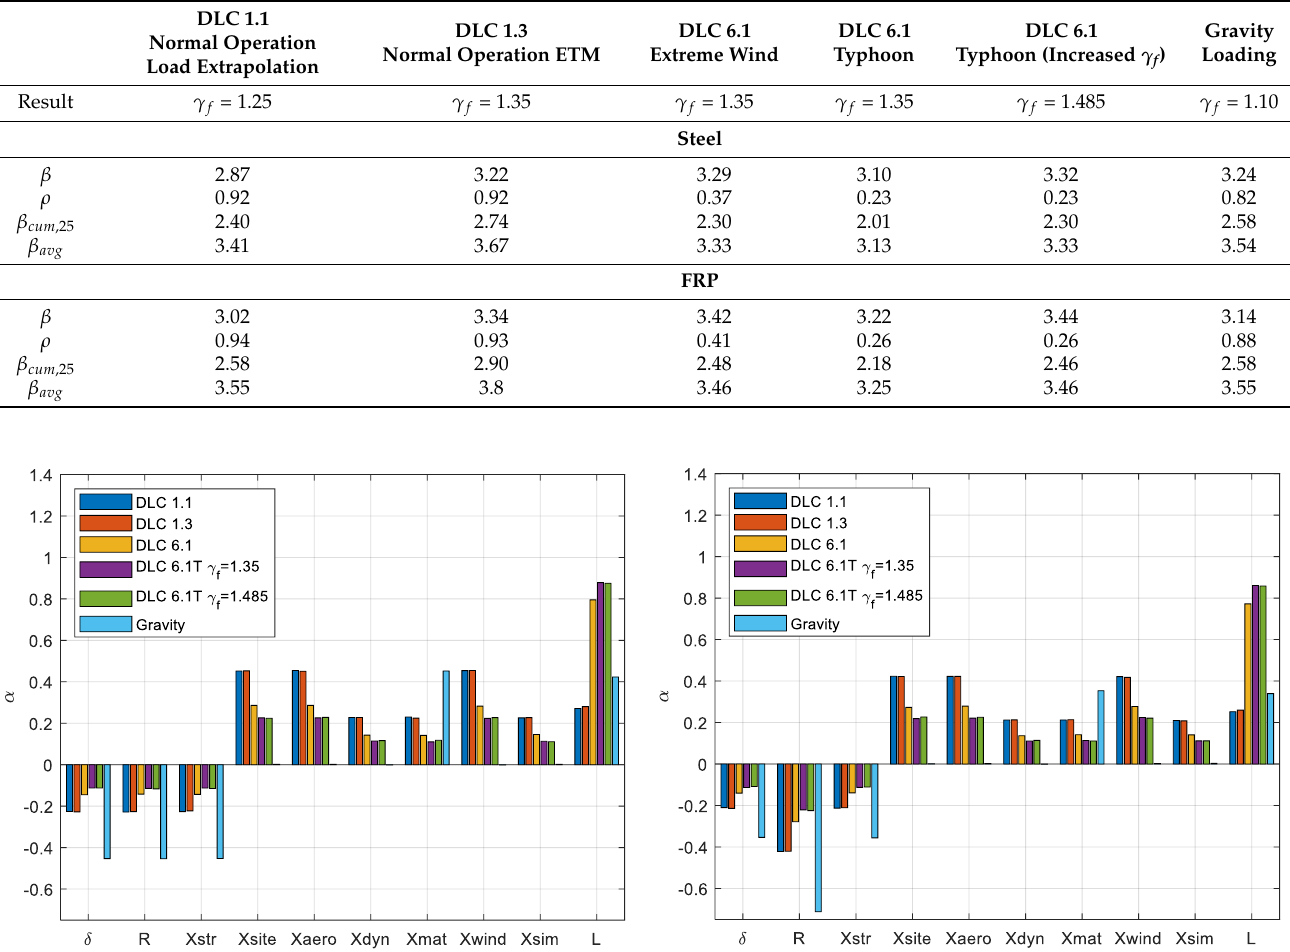
( b ) Figure 3. Reliability index as a function of time for steel, component class 2: ( a ) annual reliability index; ( b ) cumulative reliability index.